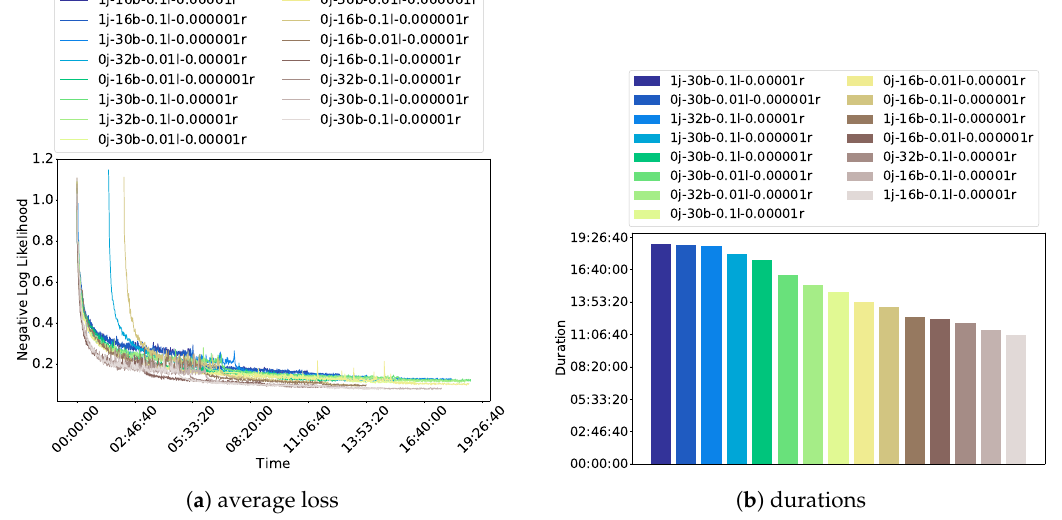
Figure 6. Average loss and duration are the main features we used for measuring progress and are show here. From ( a ) we can see that the possibility of reaching the 5000 steps without progress limit inasmuch as average loss increases. From the overall durations in ( b ) we appreciate that the maximum duration is only about 19 and a half hours. The experiments were named according to the following naming convention: <jittering was used> j - <batch size> b - <initial learning rate> l - <minimum learning rate> r . Each of these experiments was tested using a I7 Intel Core with 32 GB of RAM and 11 GB GPU, namely using a NVIDIA GeForce GTX 1080 Ti. Images more than 4,000,000 squared pixels were too big for the GPU and triggered a CUDAMalloc (memory allocation)